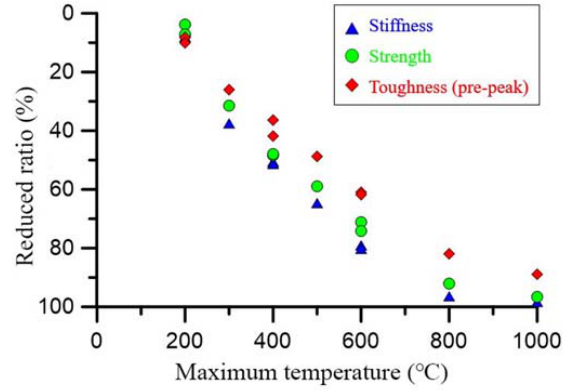
Figure 6. Maximum temperature effect on stiffness, strength, and pre ‐ peak toughness.